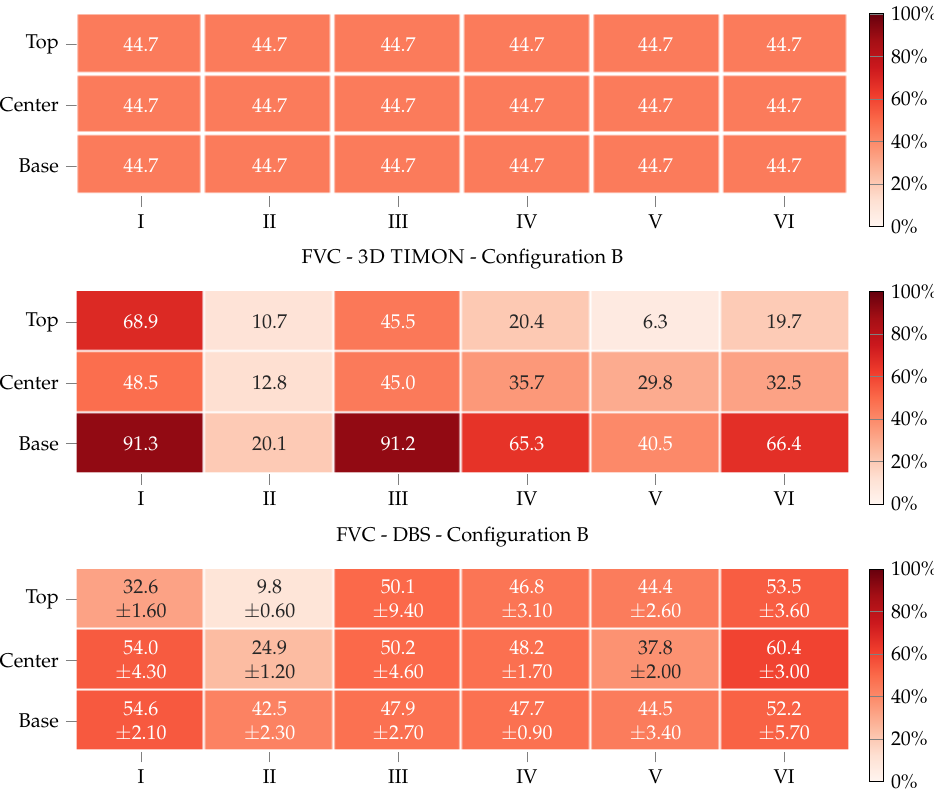
Figure 15. Fiber volume content of Configuration B according to M OLDEX 3D, the Direct Fiber Simulation and the Direct Bundle Simulation. The experimental results are shown in Figure